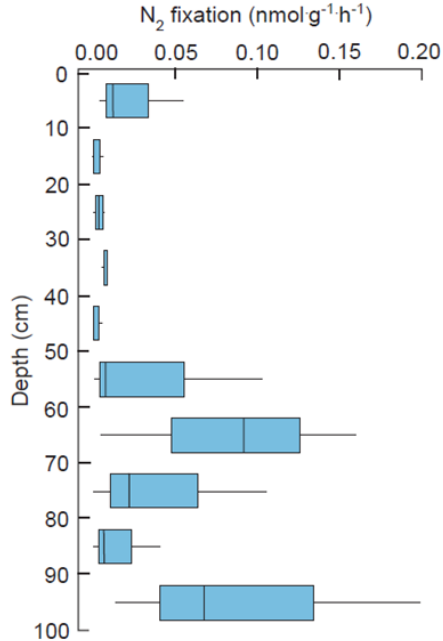
Figure 4. Rates of nitrogen fixation over a 1 m depth profile, Qi’ao Mangrove Wetland Park, China. Boxplots depict the 25 – 75% quantile range of the measurements with the centerline depicting the median (50% quantile). Whiskers show the minimum and maximum values. Adapted from Luo et al. [132]. Reproduced via requirements of open access under the CC Attribution 4.0 International